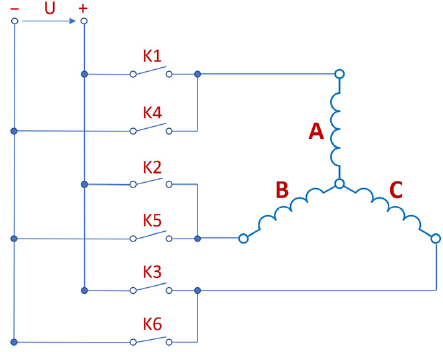
Figure 2. Electrical diagram of the motor with control keys.